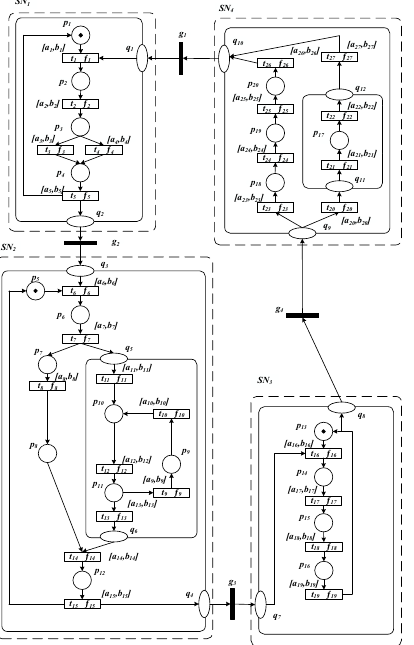
Figure 5. Embedded control system model of a smart restaurant Σ = {𝑁, 𝐹, 𝐺, 𝑀} . In Figure 5, t 1 : request restaurant data; t 2 : obtain display data; t 3 : submit meal